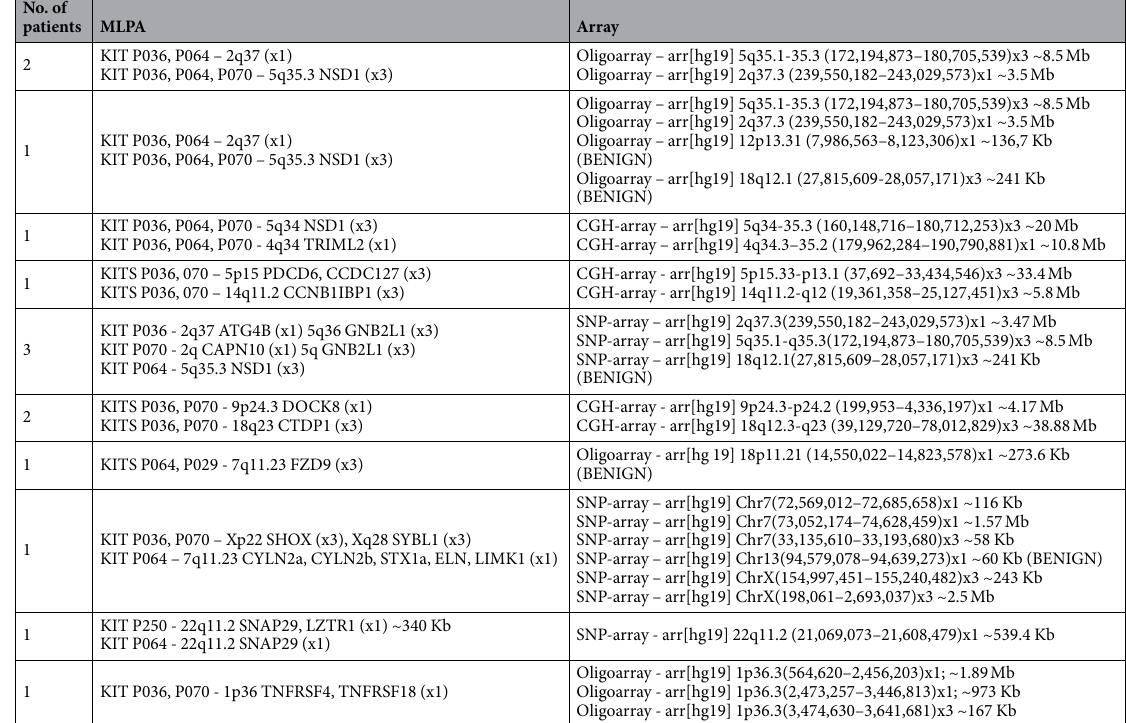
Table 3. Comparision between MLPA vs. array results performed on the same